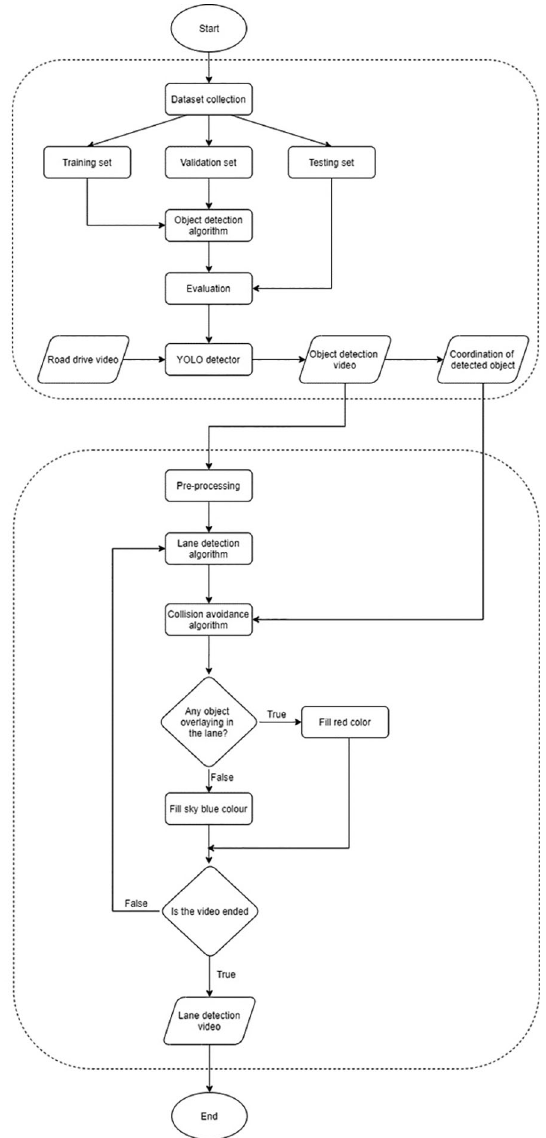
Figure 12. Flowchart of the proposed